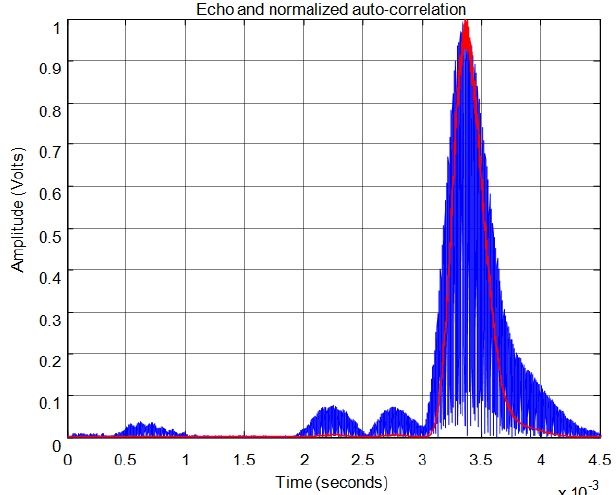
Figure 28. Normalized echo and auto-correlation for an echo formed by three overlapping sub-echoes.